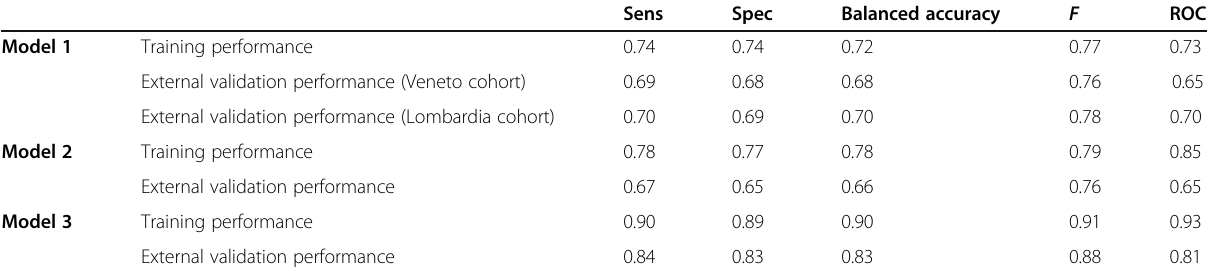
Table 2 Training and test validation